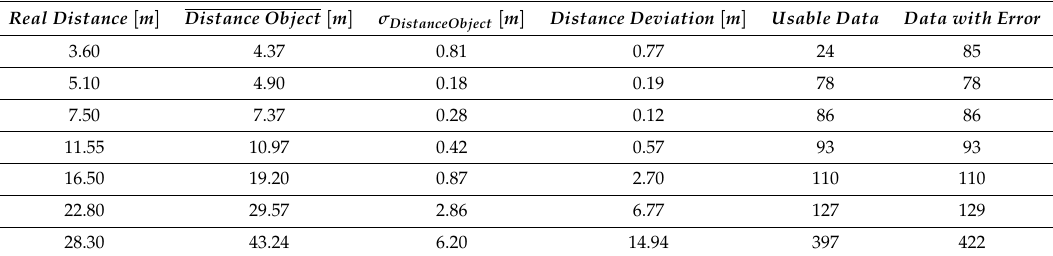
Table 2. Measurement results of the test vehicle Testcar1.